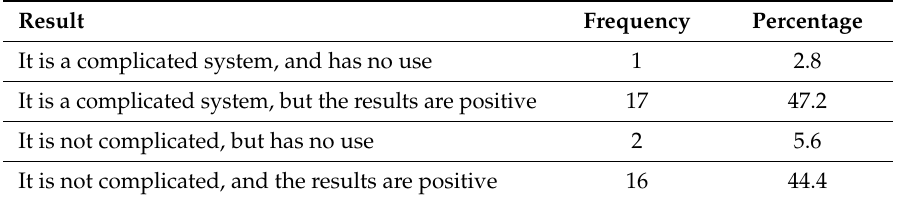
Table 25. Results of BSC implementation (N = 36).